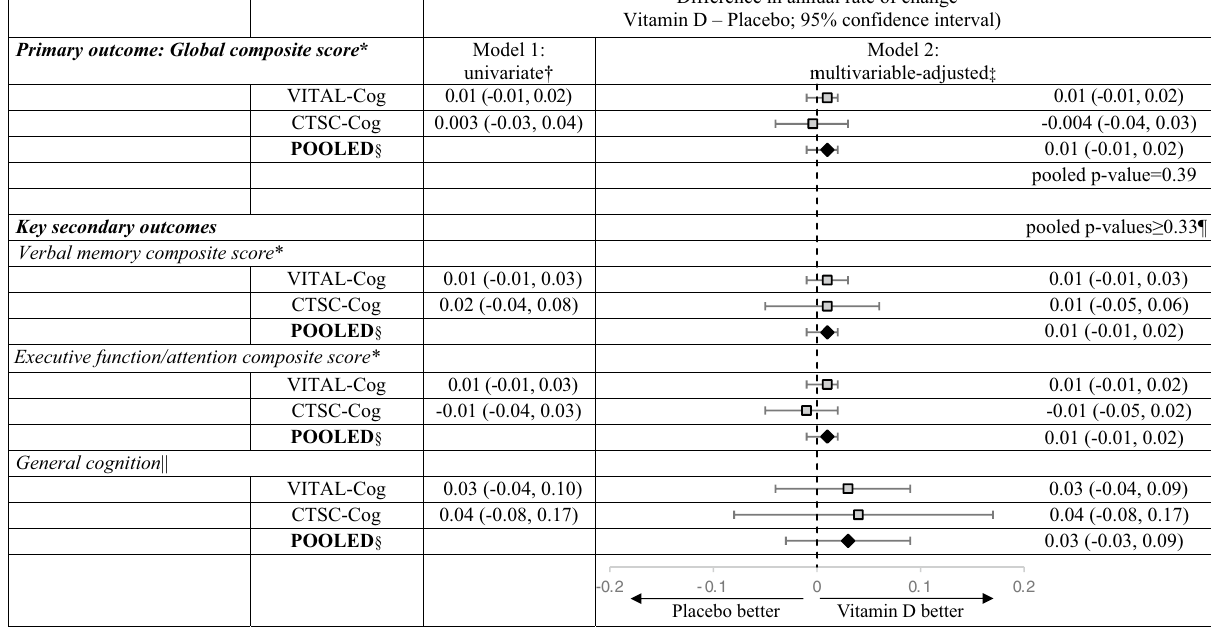
for Table 2. b From linear mixed models of cognitive performance: model 1 includes time since randomization modelled as a continuous variable, vitamin D assignment, and their interaction. c From linear mixed models of cognitive performance: model 2 is model 1 with adjustment for 6 additional variables, omega-3 assignment (yes/no), sex (male/female), age at randomization (years), race/ethnicity (non-Hispanic white, black, other race/ ethnicity), education (high school or under, college, graduate school), history of depression (yes/no; see footnote in Table 1 for definition), and the six interaction terms (products with time since randomization). d Pooled using Dersimonian and Laird fixed-effects method for meta-analysis 40 except for general cognition where the p for heterogeneity across the two substudies was 0.04 and results were meta-analyzed with random-effects. e Due to the differences in scale between the TICS (0–41) used in VITAL-Cog and 3MS (range 0–100) used in CTSC-Cog, for pooling purposes, the 3MS scores were multiplied by 0.41 for conversion to the same scale as the TICS scores. As the p for heterogeneity across the two substudies was 0.04, the results were meta-analyzed with Dersimonian and Laird method incorporating random-effects 40 . f None of the effects for the secondary outcomes were significant at Bonferroni-adjusted p-value of 0.0167 (= 0.05/3 secondary